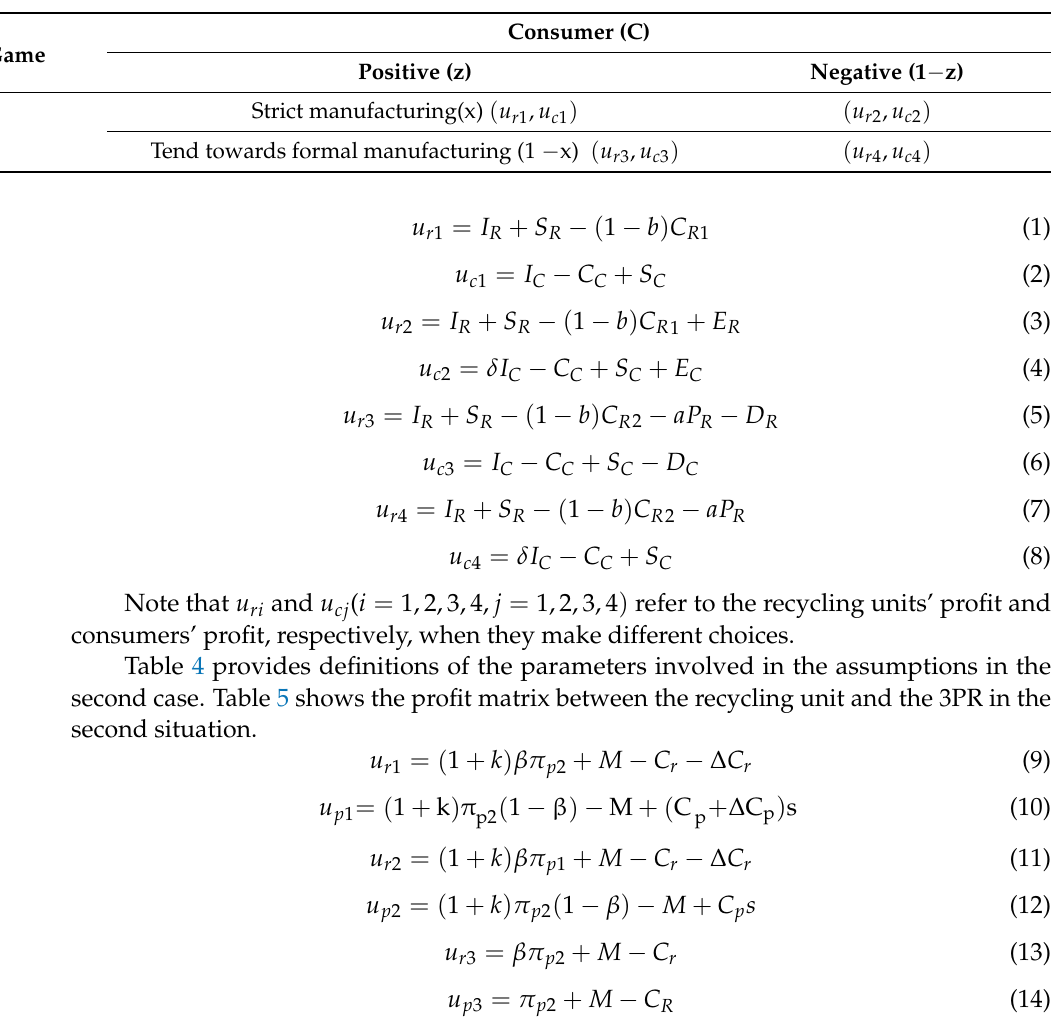
Table 3. Game profit matrix between recycling units and consumers in the first situation.